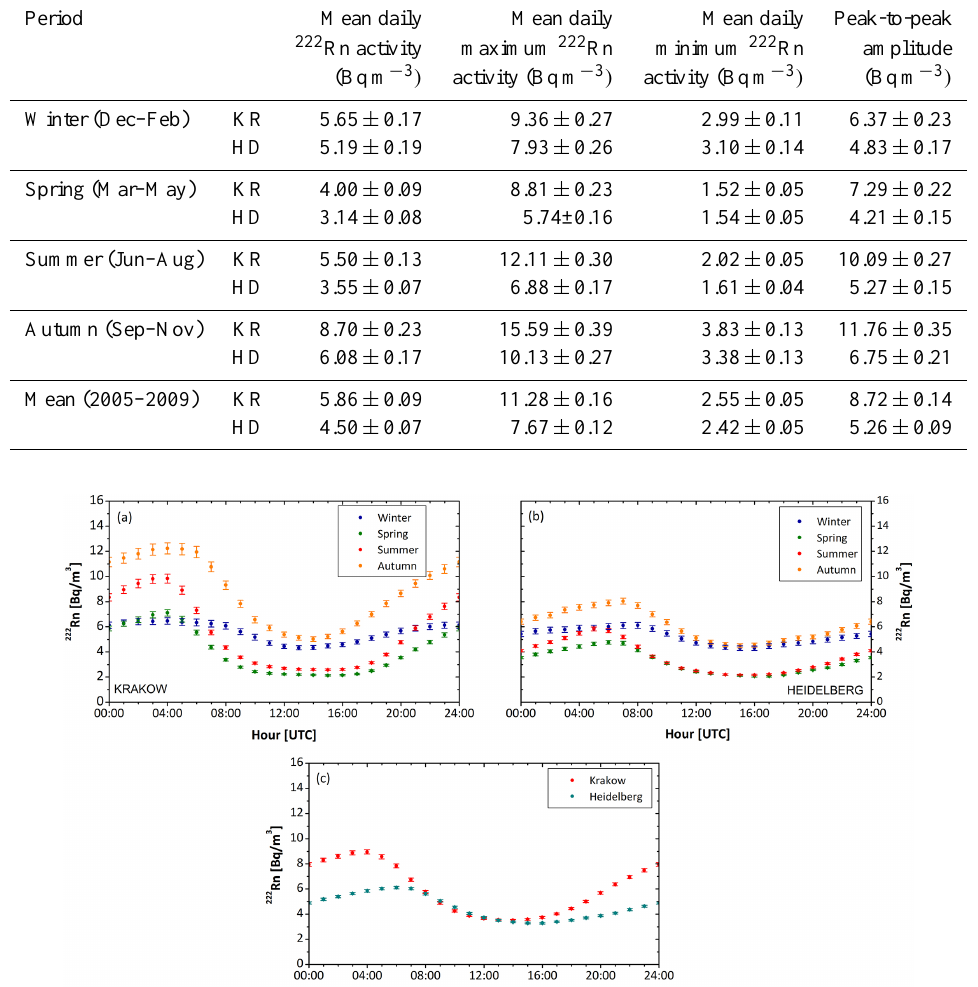
Table 1. Indicators of daily variations of 222 Rn activity in Krakow (KR) and Heidelberg (HD) during the period January 2005–December 2009. The quoted uncertainties represent standard uncertainties of the mean values. Period